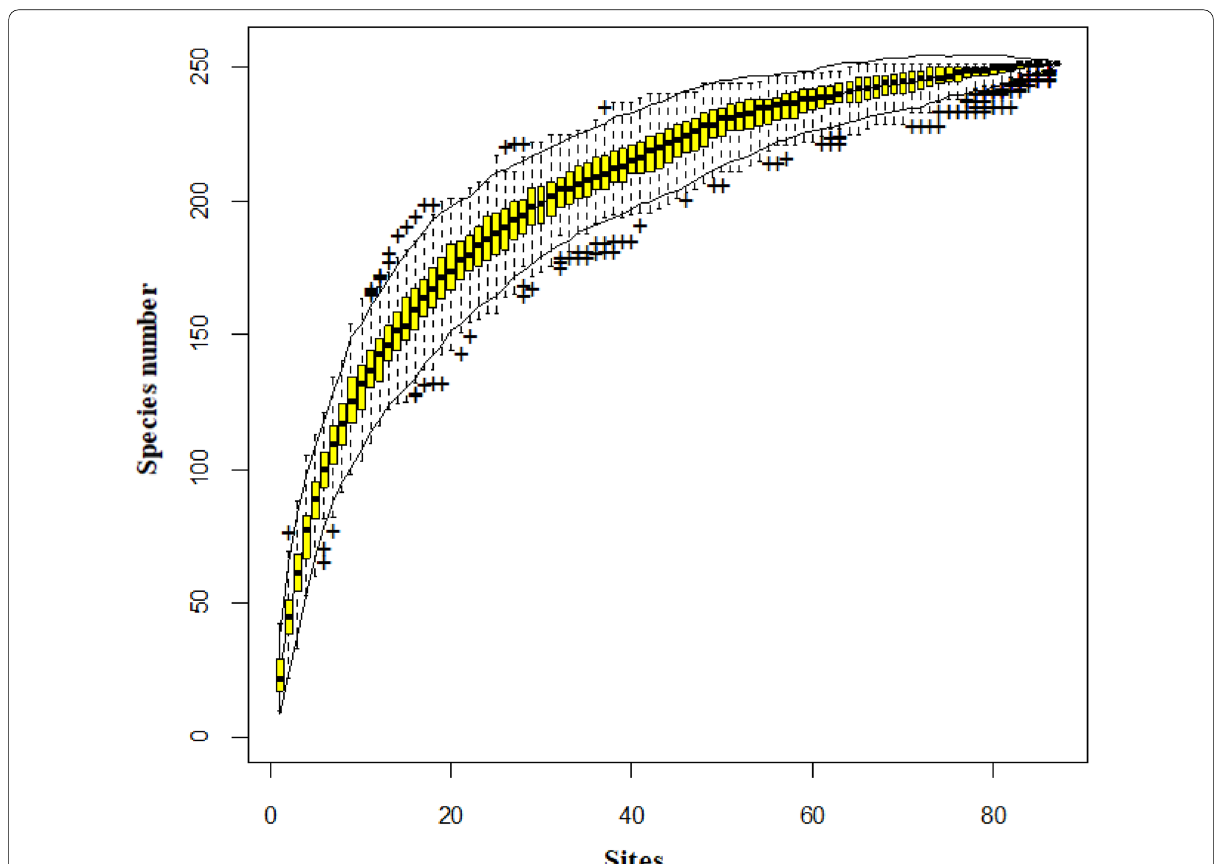
Fig. 4 Species accumulation curve showing the relationship between the numbers of sites or quadrats and the number of plant species in Sele-Nono